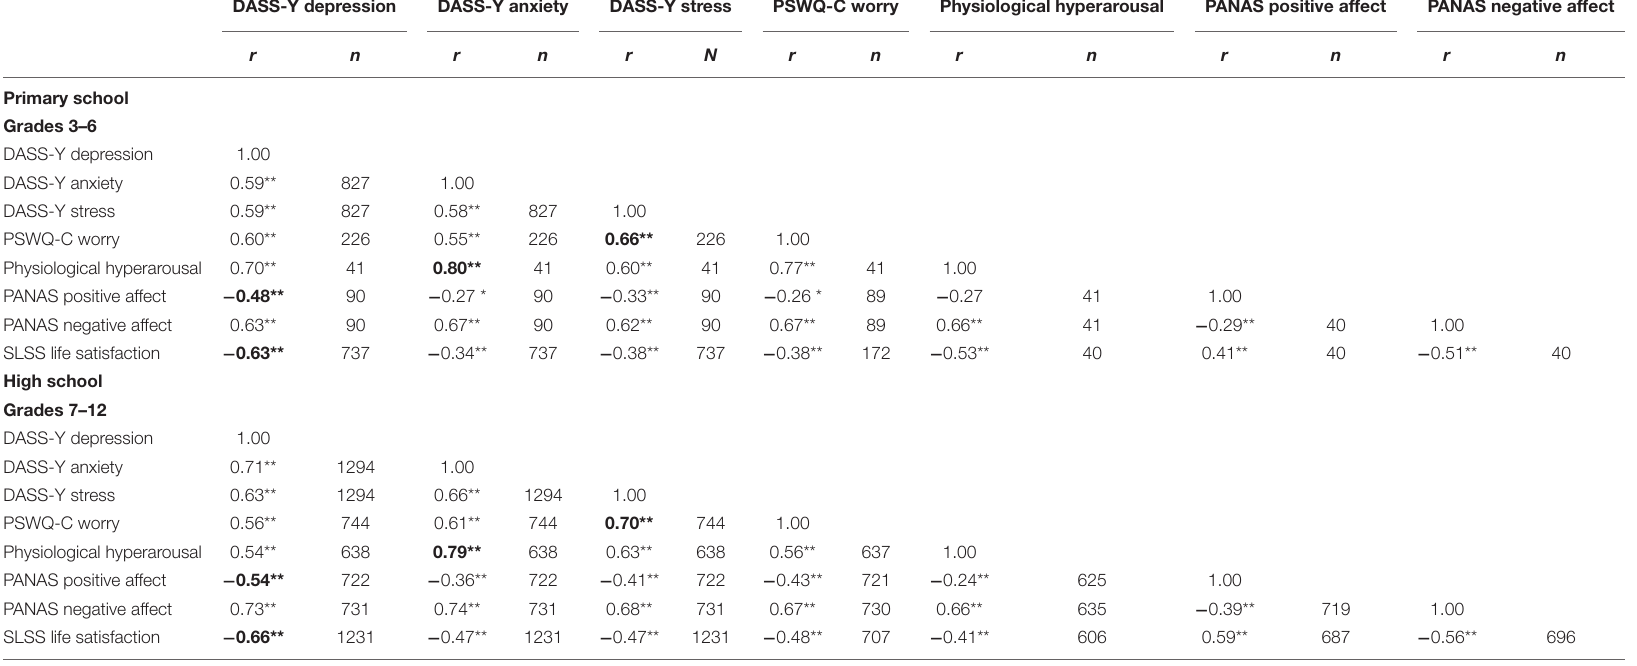
TABLE 6 | Correlations between the DASS-Y scales and other measures in primary school and high school students. DASS-Y depression DASS-Y